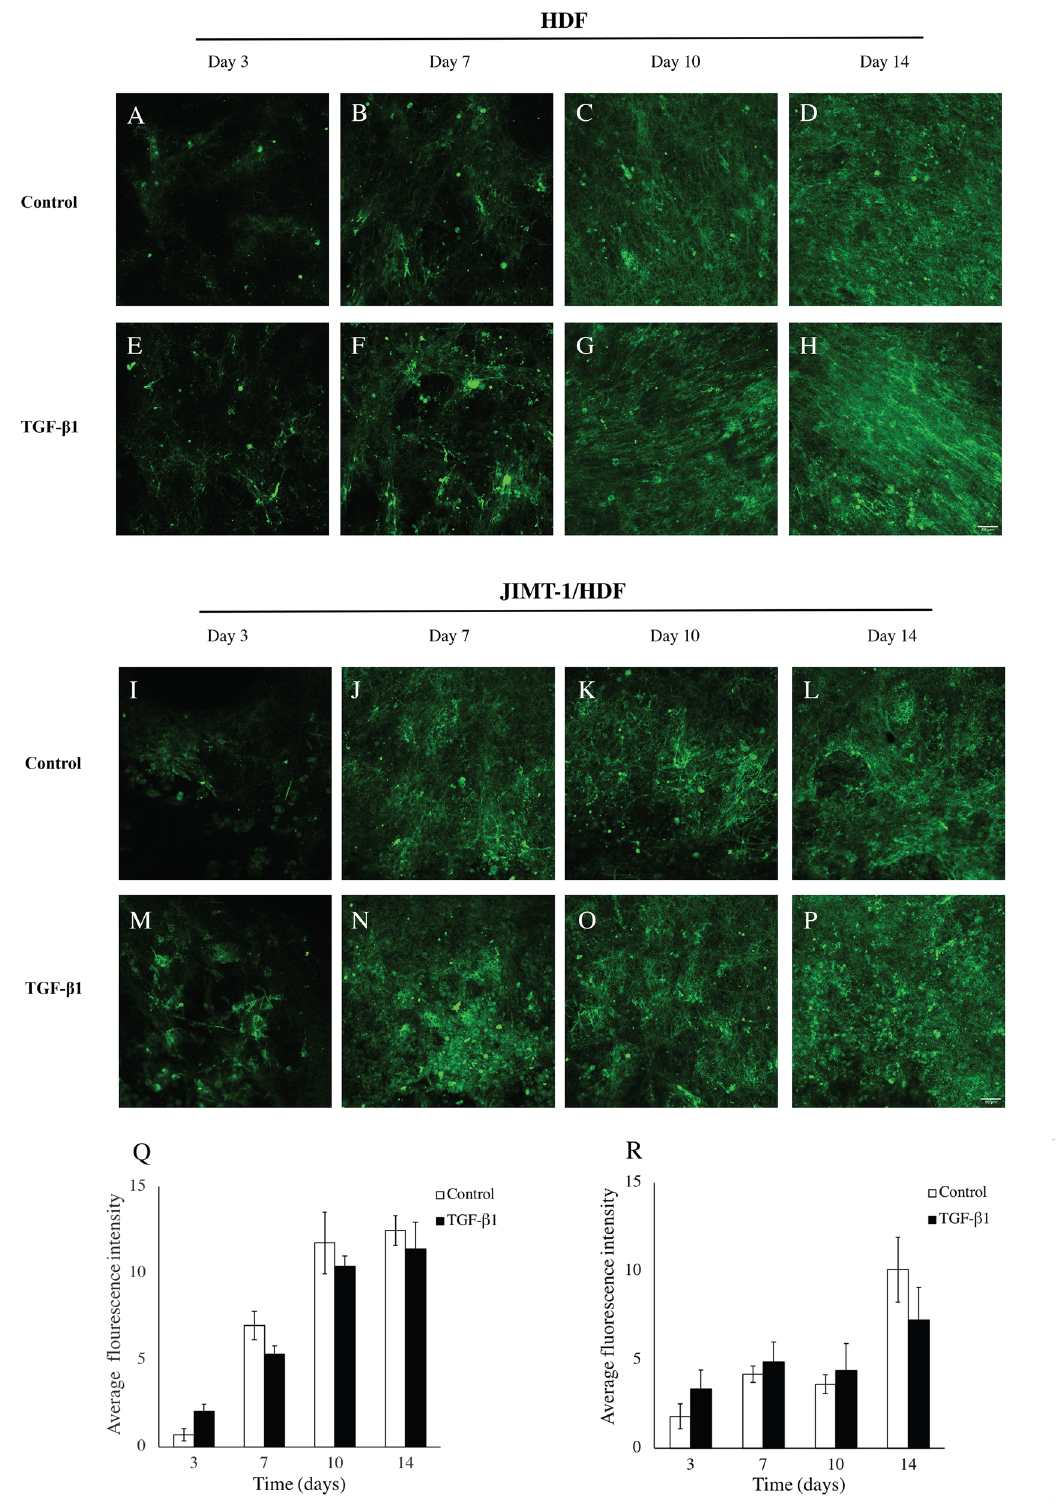
Figure 3. Laminin deposition, localization, and quantification in decellularized scaffolds of HDF and JIMT-1/ HDF 3D cultures. ( A – P ) Single confocal plane images of laminin deposition taken in the centre of decellularized 3D cultures incubated in the absence (control) or presence of 5 ng/ml TGF-β1. The 3D cultures were decellularized, fixed in 3.7% formaldehyde and stained to visualize fibronectin (green) at 3, 7, 10, and 1 days of culturing. All images are representative of 3 independent experiments. Scale bar is 50 μm. Quantification of fluorescence intensity using ImageJ in images taken by epifluorescence microscopy in HDF decellularized scaffolds ( Q ) and JIMT-1/HDF decellularized scaffolds ( R ). The columns are represented as mean ± SEM (n =